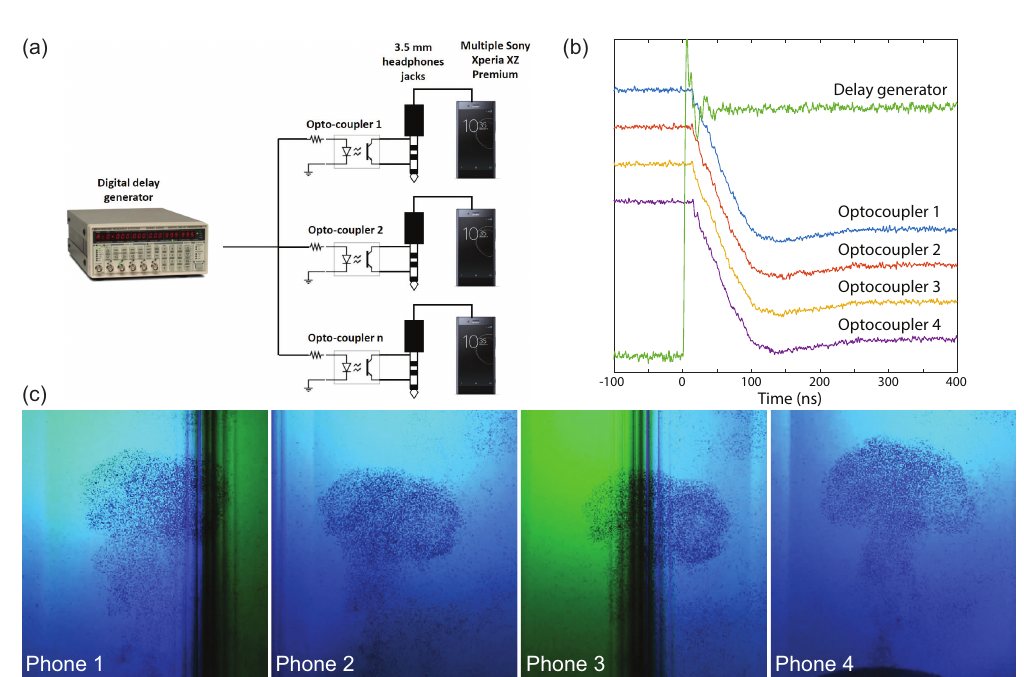
Figure 2. ( a ) Schematic representation of the synchronization system, proposed for simultaneous capturing high-speed video at 960 fps by multiple smartphone cameras. The TTL signal is generated by a digital delay generator. This signal is sent in parallel to multiple optocouplers that trigger the Xperia TM XZ cameras through the headphone jack. ( b ) Signal characterization of the optocouplers versus the trigger signal from the digital delay generator. The typical response time of the optocoupler is approximately 150 ns. ( c ) Images of a vortex ring captured close to the same time. One can note that the scanning of the sensor produces overlapped flashes in phones 1 and 3. Whereas for phones 2 and 4 the flash is in phase with the recorded